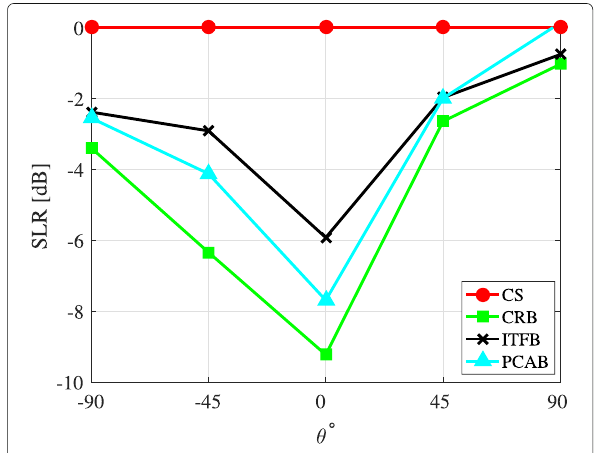
Fig. 4 Computed SLR as a function of azimuth angle for different speech blocking algorithms, where SNR = − 5